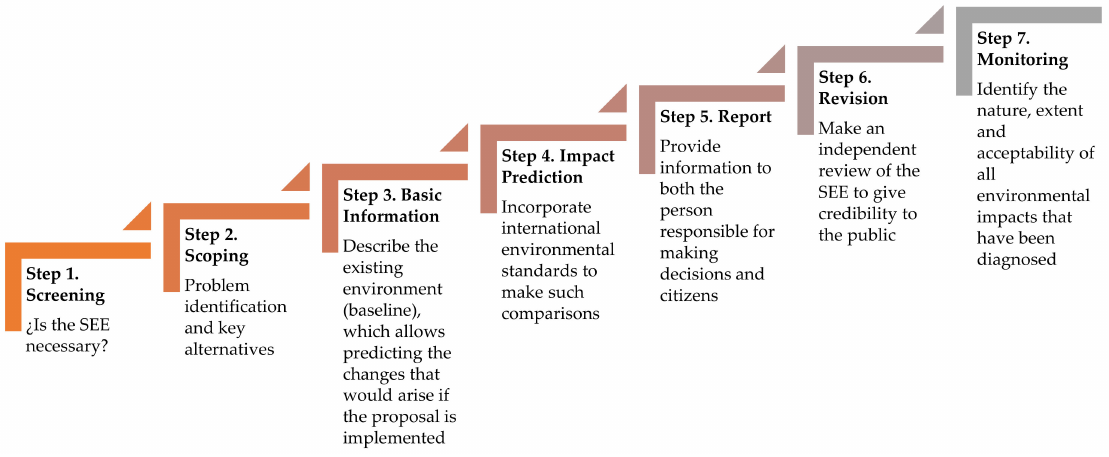
Figure 4. Strategic environmental evaluation (SEE)